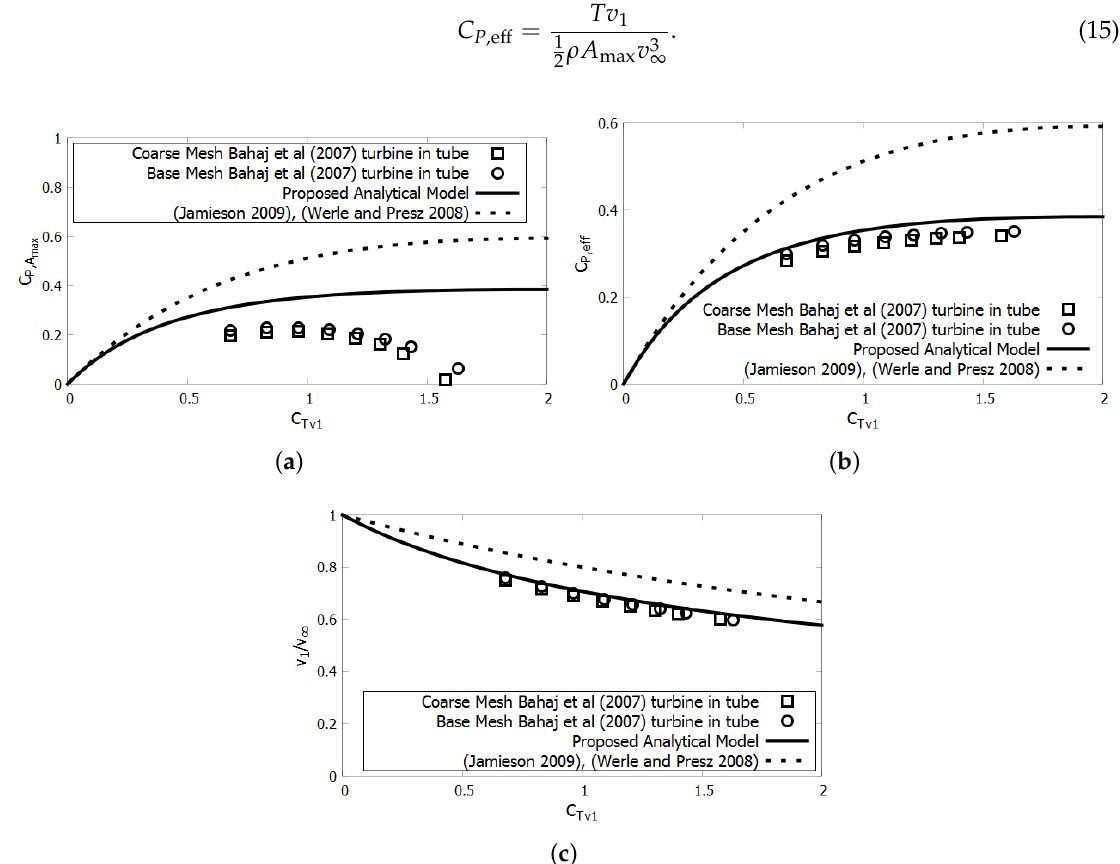
Figure 9. Analytical models along with the CFD of Bahaj et al. turbine [15] in a tube with diameter equal to duct throat diameter. ( a ) C P , A